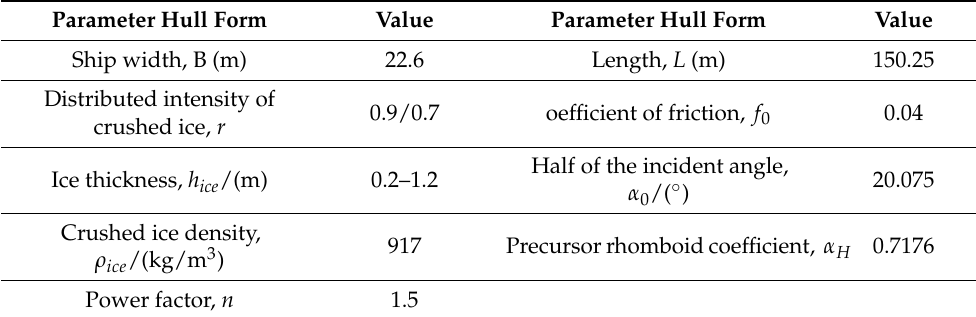
Table 12. DuBrovin calculation parameters selected for this ship model (traditional icebreaker bow).